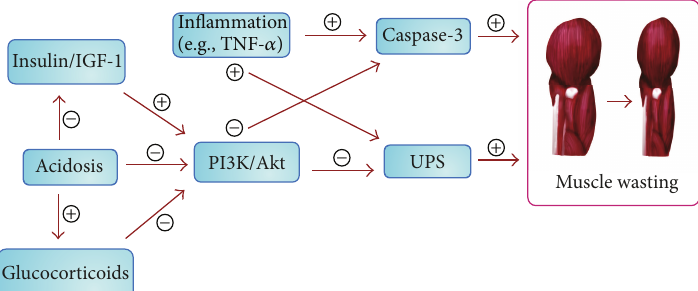
Figure 1: Molecular mechanisms and signaling pathways of muscle wasting in hemodialysis patients. UPS, ubiquitin-proteasome system; IGF-1, insulin-like growth factor-1; PI3K, phosphoinositide 3-kinase; TNF- 𝛼 , tumor necrosis factor- 𝛼 .